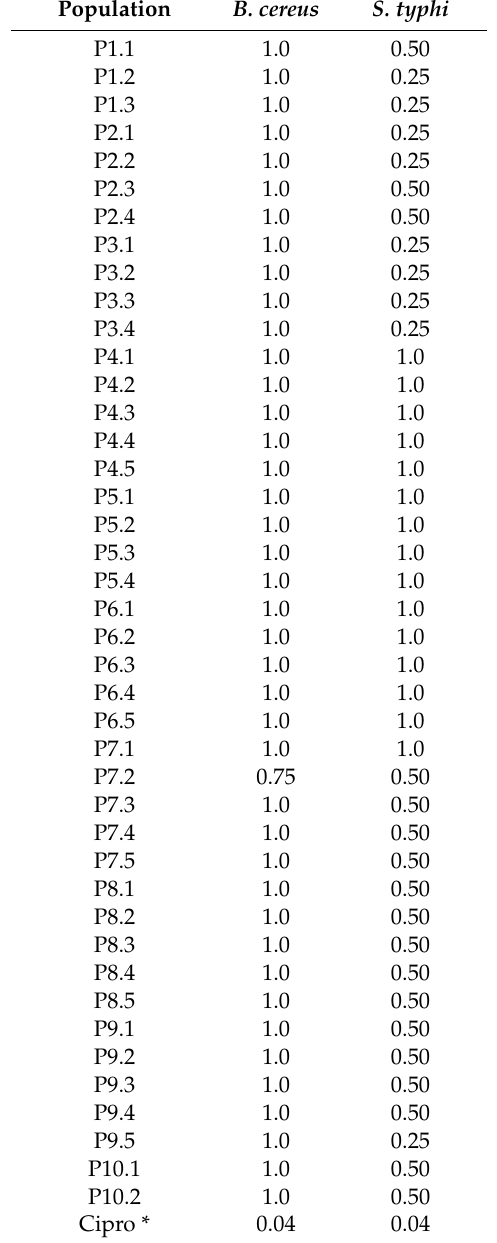
Table 2. Variation in antibacterial activities as reflected by the MIC (mg / mL) of dichloromethane: methanol extracts of T. sericea root bark collected from di ff erent